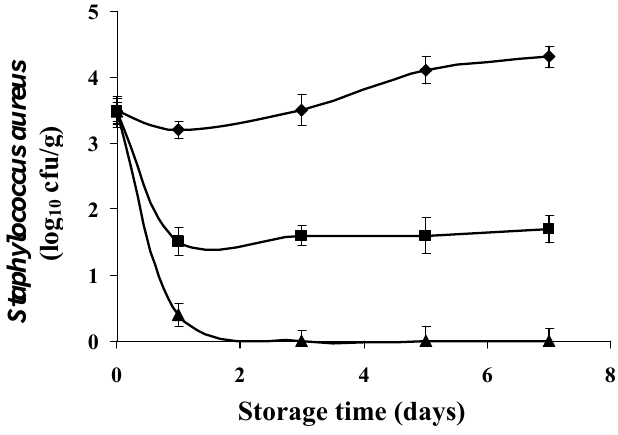
Figure 6. Inhibition growth of S . aureus by bergamot EO at different concentrations in Sardina pilchardus stored at 8 ± 1 °C under aerobic conditions. (  ) Control; (  ) C . aurantium (1  MIC value); (  ) C . aurantium (4  MIC value). Error bar represents the standard deviation for triplicate experiments.